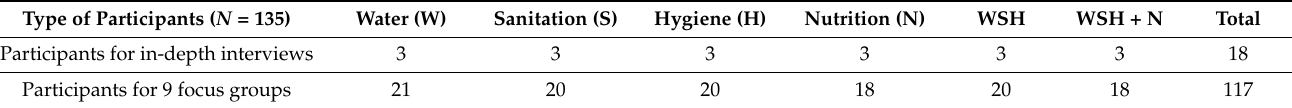
Table 1. Distribution of CHW participants by assigned intervention arm and data collection